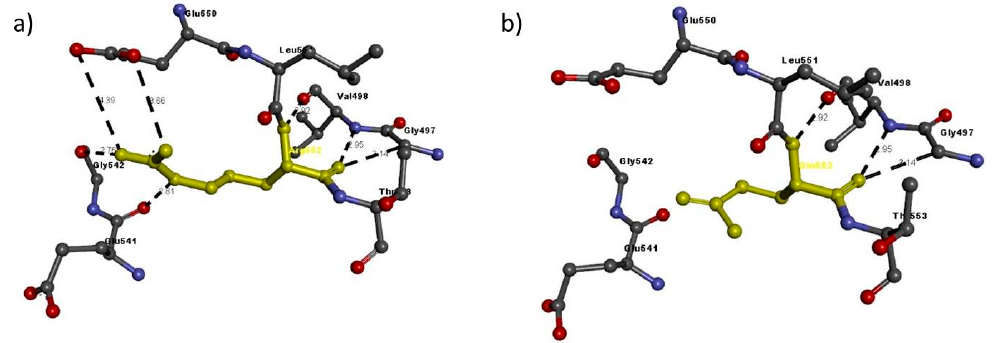
Figure 6. Molecular interactions of ( a ) Arg552 and ( b ) Gln552 (in yellow) of the modeled NRP1 protein with adjacent residues.